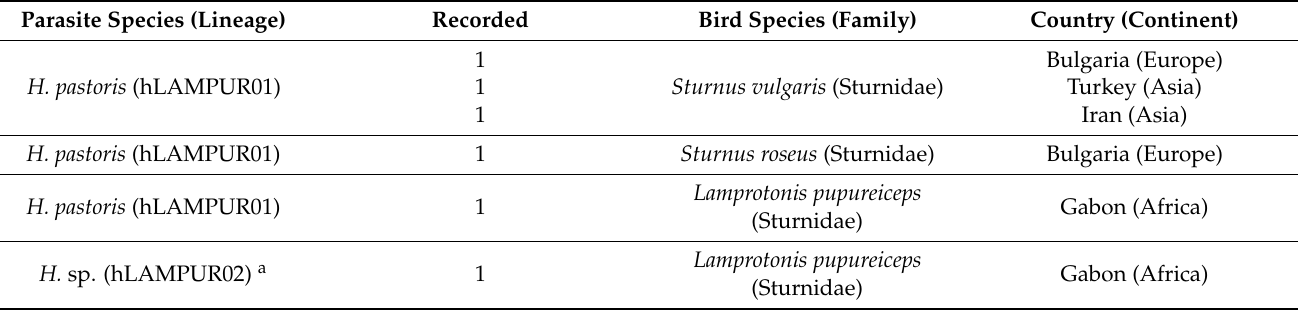
Table 2. Molecular records of H. pastoris (lineage hLAMPUR01) and non-identified to species level closely related lineage hLAMPUR02 in these avian hosts, according to MalAvi database [3], July 2021. Parasite Species